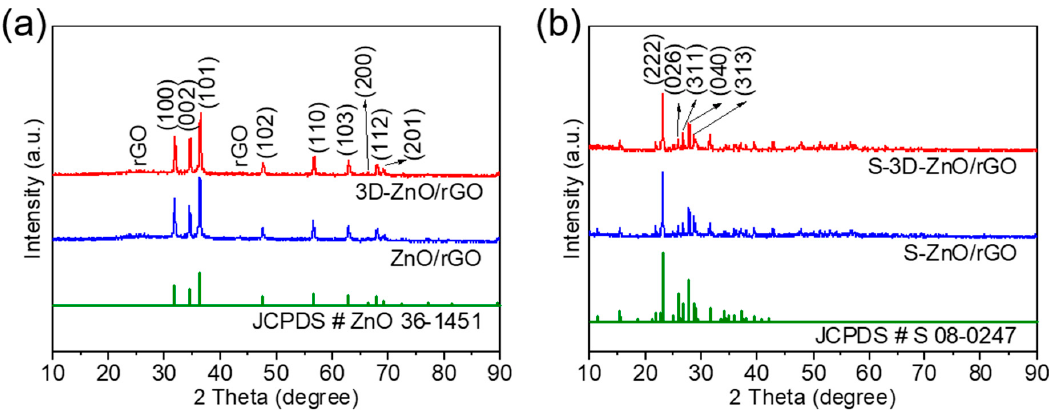
Figure 5. XRD spectra of ( a ) ZnO/rGO and 3D-ZnO/rGO composites, ( b ) S-ZnO/rGO and S-3D-ZnO/rGO composites.